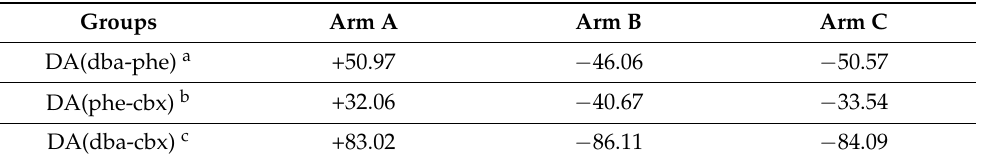
Table 1. a Dihedral angle ( ◦ ) between the dehydrobenzoannulene (DBA) core and the peripheral phenylene group. b Dihedral angle ( ◦ ) between the phenylene and carboxylic groups. c Dihedral angle ( ◦ ) between the DBA core and carboxylic